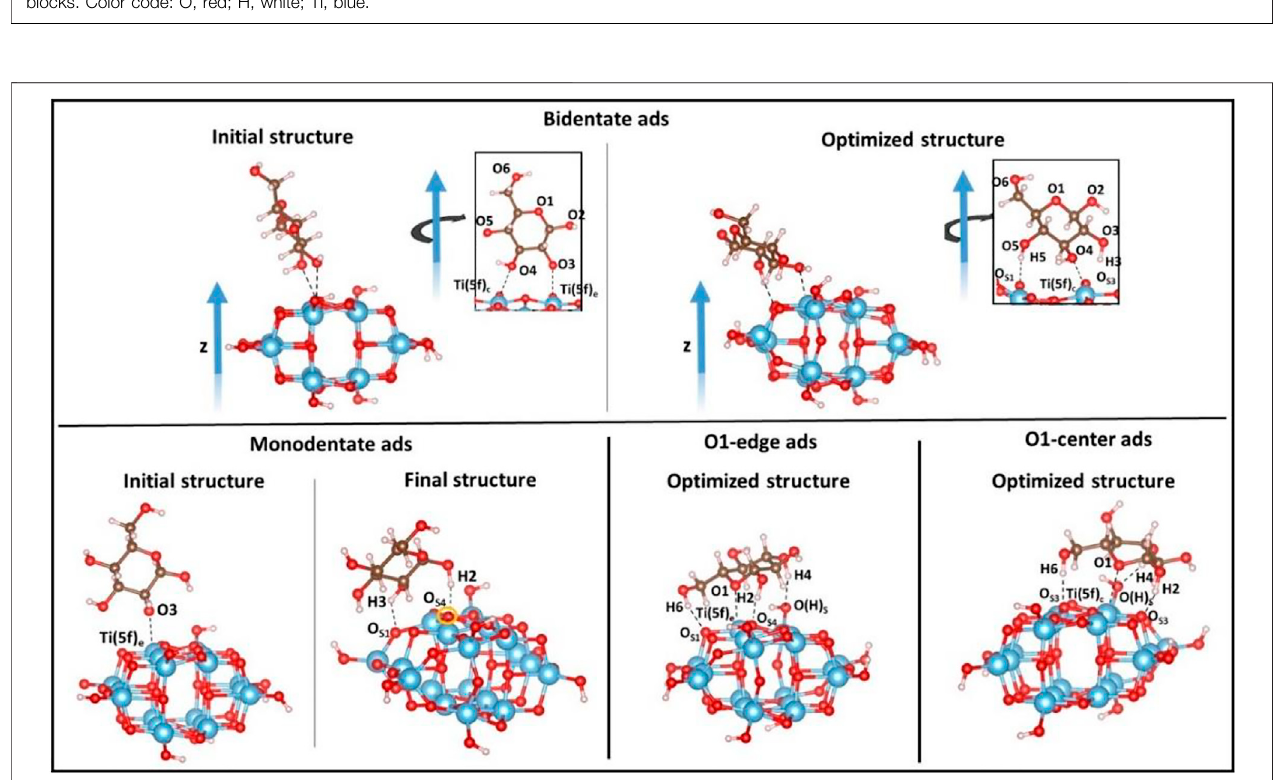
FIGURE 3 | Different adsorption modes of D -glucose on the TiO 2 anatase (100) cluster surface investigated in this work. Color code: O, red; H, white; Ti, blue; C, brown.